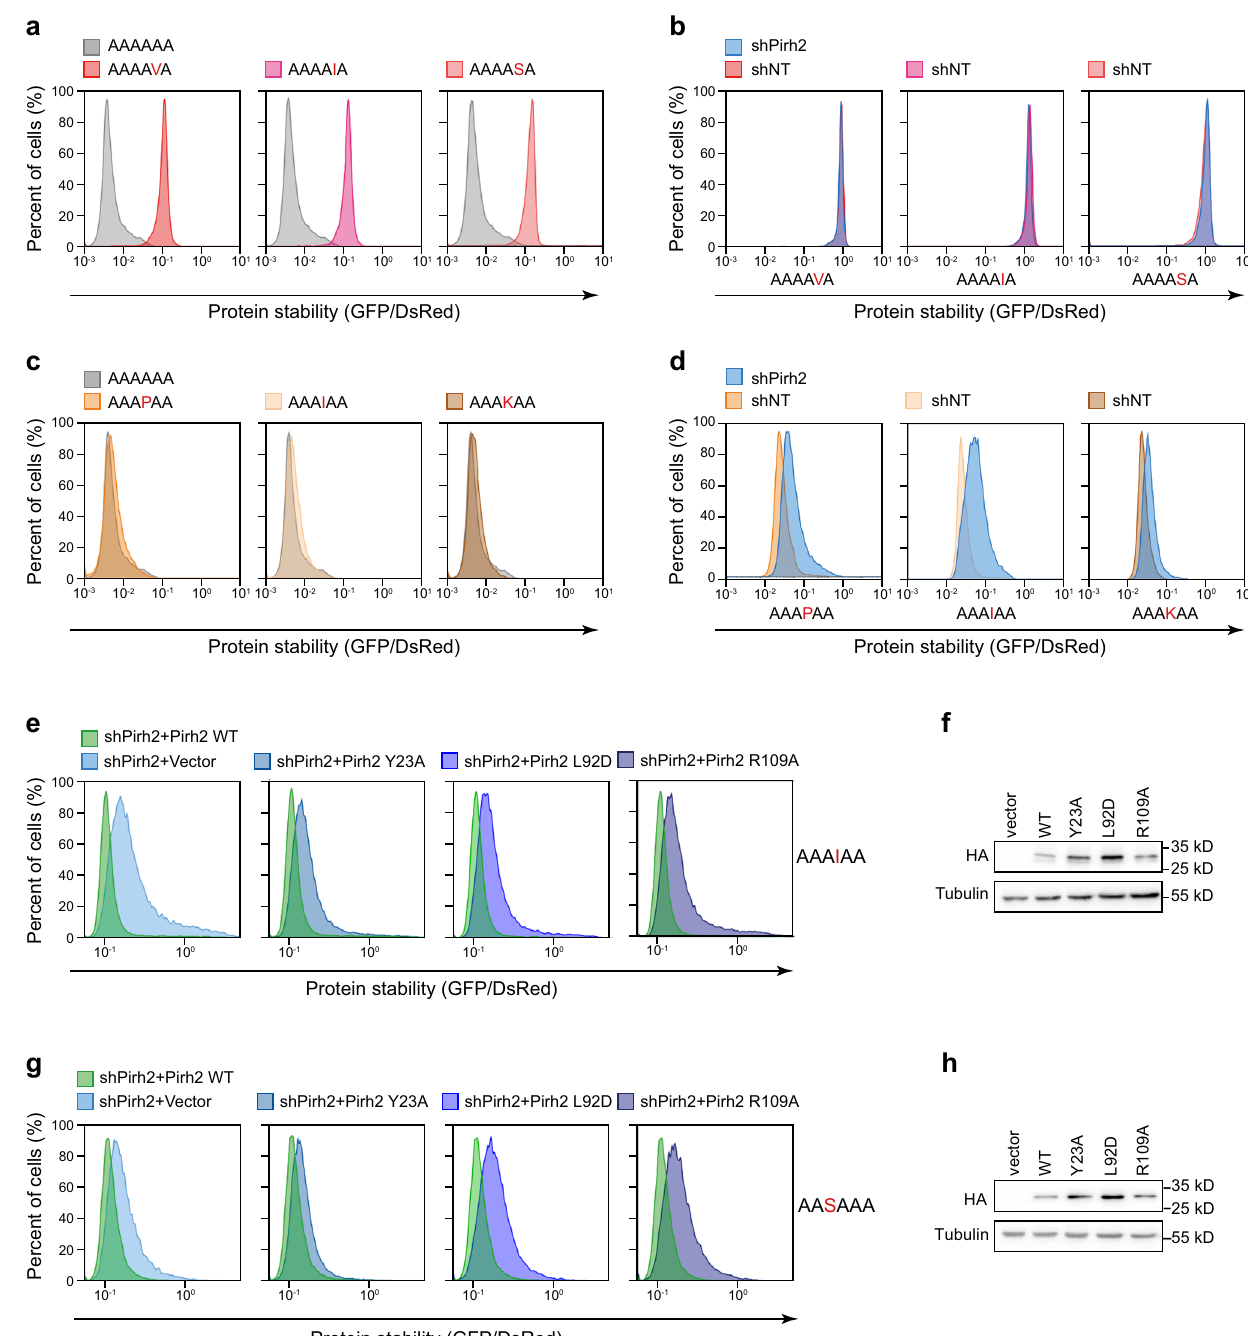
Fig. 6 | Pirh2-mediated substrate degradation in cells. a Stability comparison of GFP-fused Ala6/C-degron with Ala-2 substitutions in HEK293T cells, monitored by global protein stability assay. The ratio of GFP/DsRed was analyzed by fl ow cyto- metry. b Stability analysis of GFP-fused Ala-2 substitution C-degron in HEK293T cells with or without shPirh2 treatment. c Stability comparison of GFP- fused Ala-3 substitution C-degron to Ala6/C-degron by GPS assay. d Stability ana- lysis of GFP-fused Ala-3 substitution C-degron in HEK293T cells with or without shPirh2 treatment. e Stability analysis of GFP-fused A-I-A-A C-degron in Pirh2